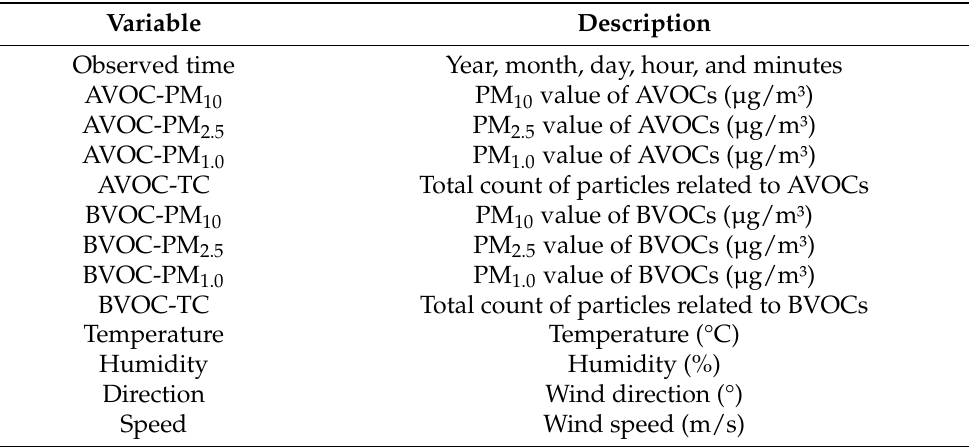
Table 1. Variables and descriptions in the datasets.